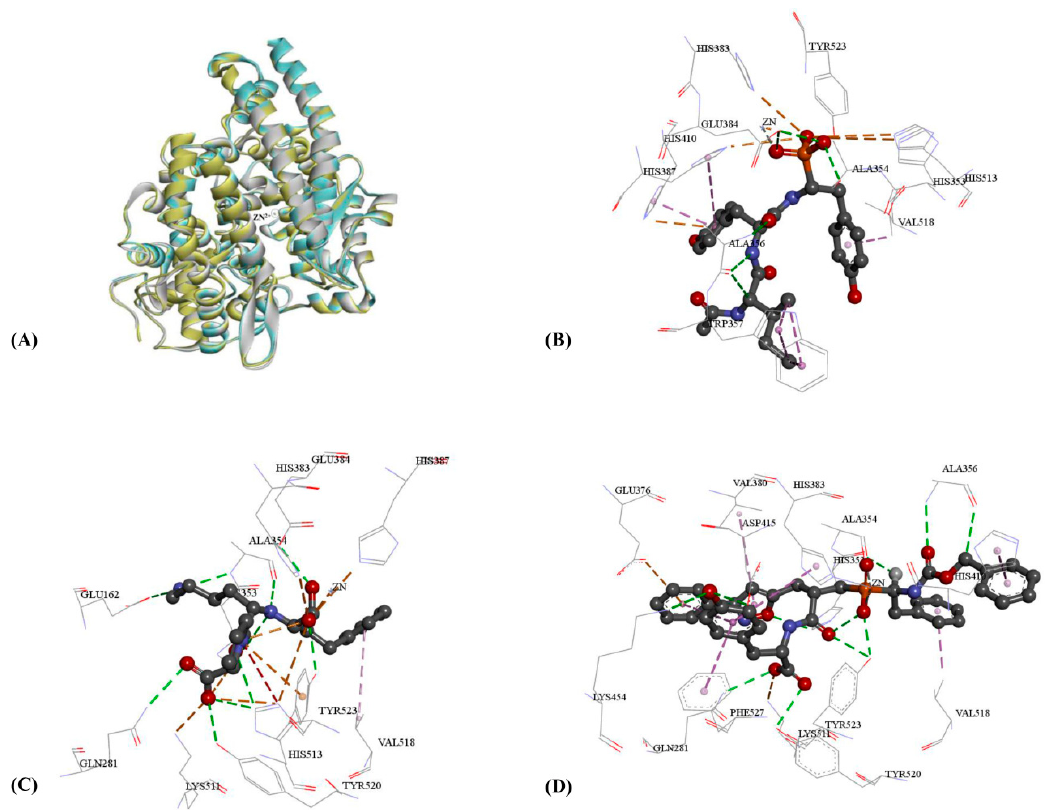
Figure 2. The 3D docking results of initial ligands and three crystal structures: ( A ) the alignment of three crystal structures with 1O86 in blue, 4BZR in grey, and 4CA in yellow; ( B ) docking results of 4BZR and K-26; ( C ) docking results of 1O86 and lisinopril; and ( D ) docking results of 4CA5 and FI. The pink dash line represented the hydrophobic effect. The green dash line represented the hydrogen bond donor. The orange dash line represented the electrostatic network.